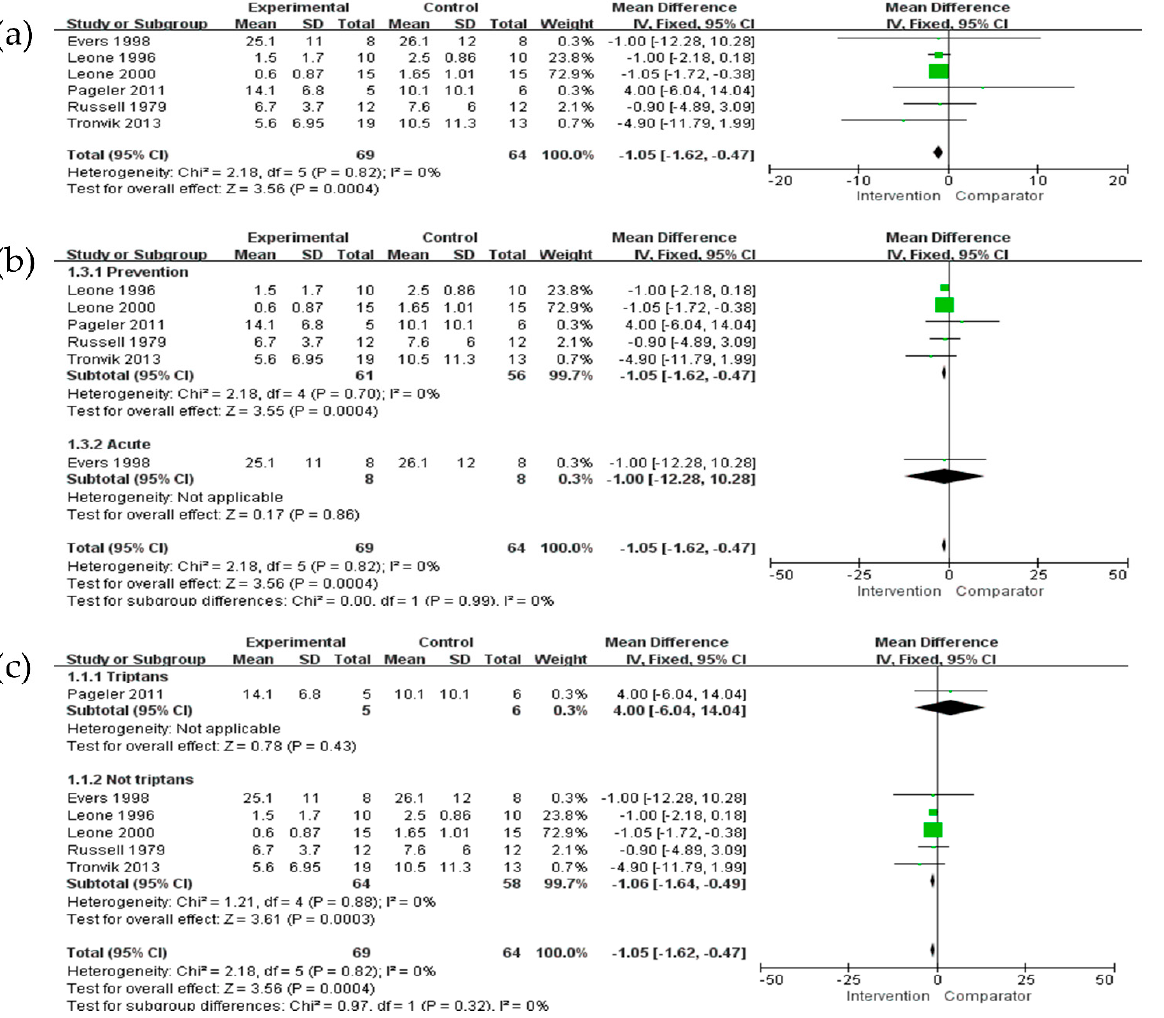
Figure 2. The effects of pharmacological treatments on frequency of attacks. ( a ) Overall; ( b ) comparison between preventive and acute; ( c ) comparison between triptan and non-triptan. Green squares indicated effect size for each of included studies and the size of green square indicates the weight assigned to that study in the meta-analysis. Black diamond suggested as meta-analyzed measure of effect. Bold letters represented a category or subtotal of each subgroup and overall outcome.